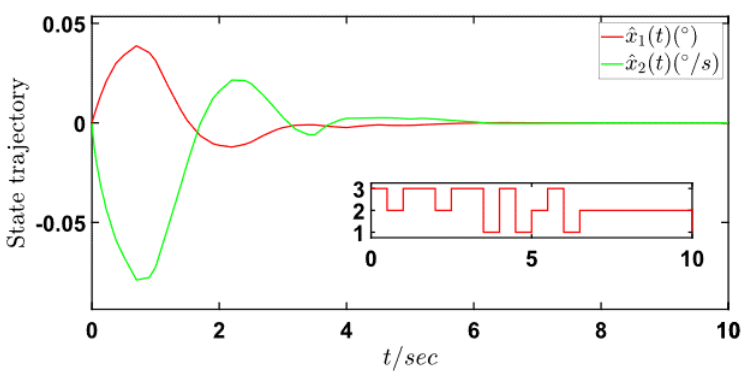
Figure 3. The state trajectories for the observer system.